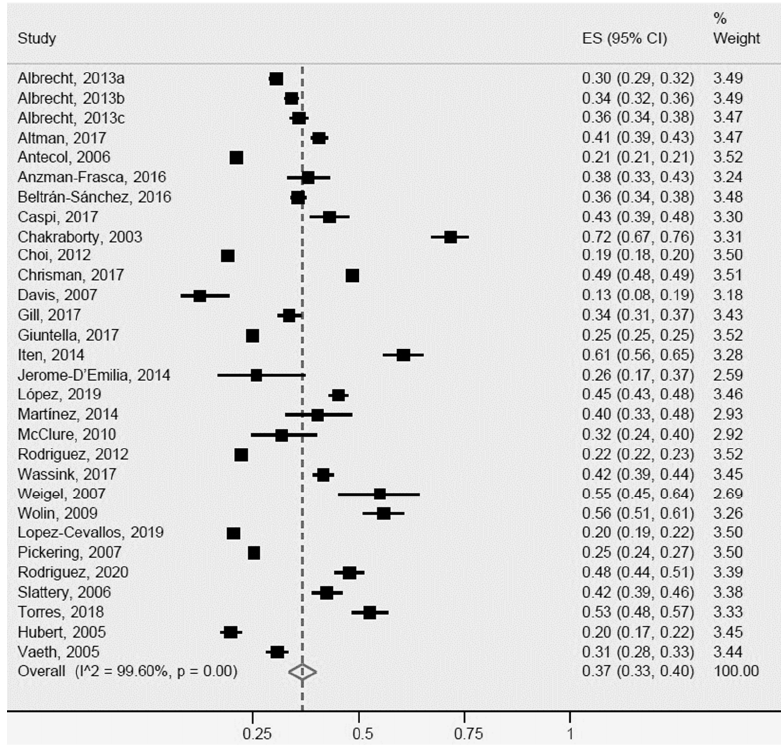
Figure 6. General obesity for Latinos in the US. ES = Estimated proportion/prevalence; CI = Confidence interval; I^2 = I 2 index. For abdominal obesity, the prevalence for Latinos determined by the meta ‐ analysis of five studies was 54% (95% CI: 48–59%, I 2 : 96.7%). Notably, all five studies were heter ‐ ogeneous (Figure 7).